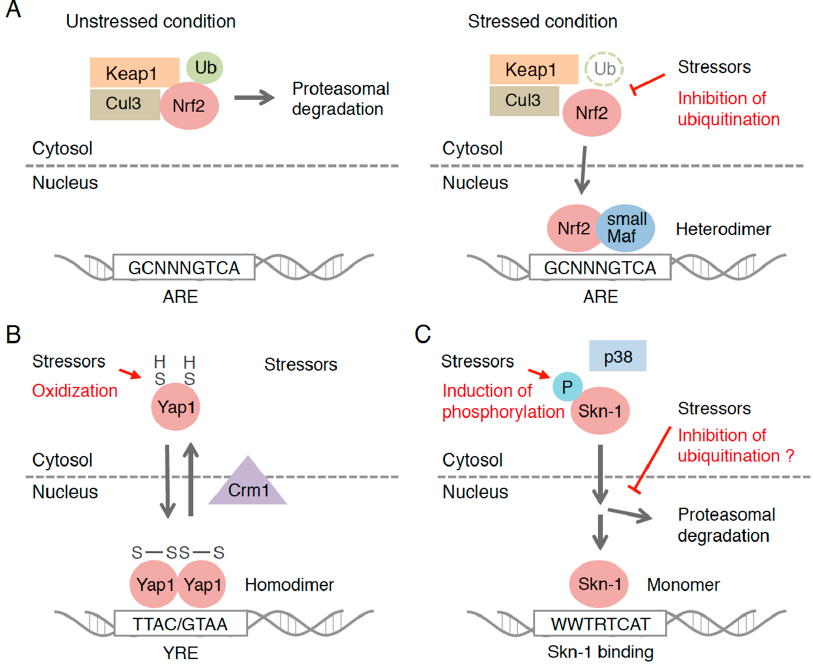
Figure 1. Regulatory mechanisms of the transcription factor-based oxidative stress response in eukaryotes. The activation mechanism of: Keap1-Nrf2/Cnc system ( A ); Yap1 in S . cerevisiae ( B ); and Skn-1 system in C. elegans ( C ) are depicted.